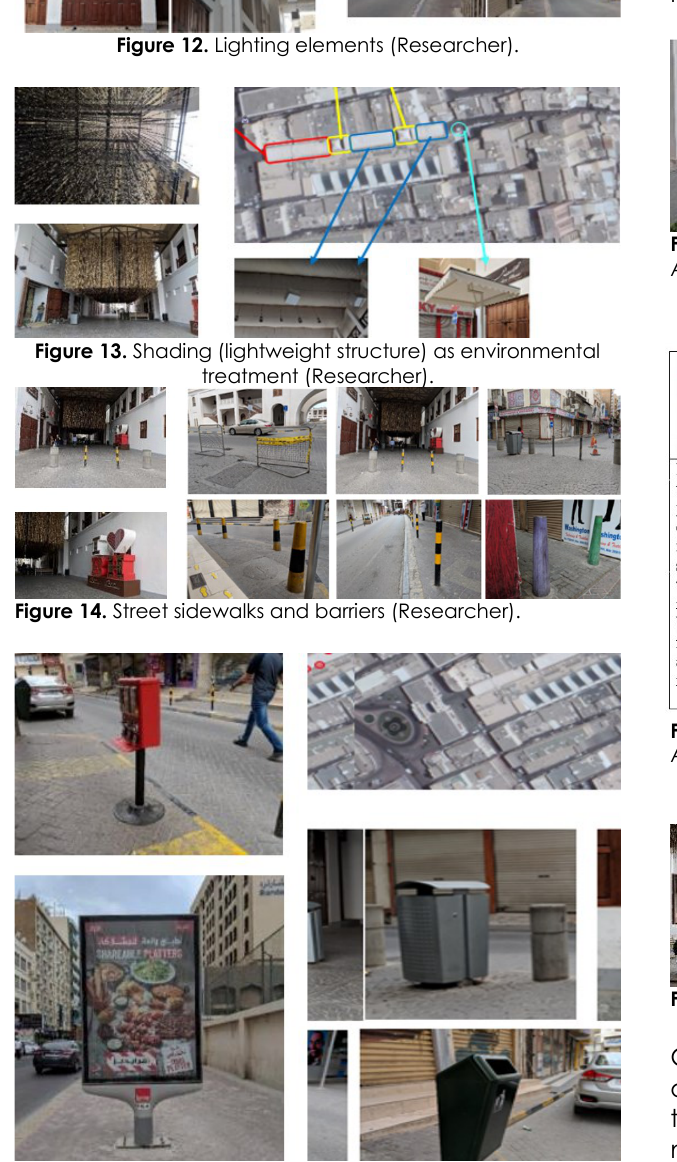
Figure 15. Signs and trash boxes (Researcher).